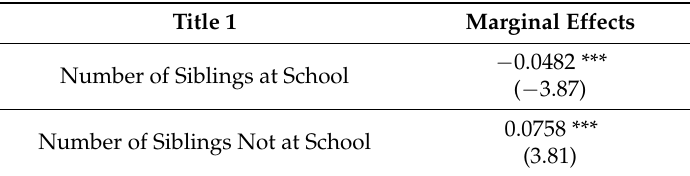
Table 1. The Marginal Effects of an Additional Sibling Enrolled or not Enrolled in School Prior to the Hurricane on the Probability a Student Continued